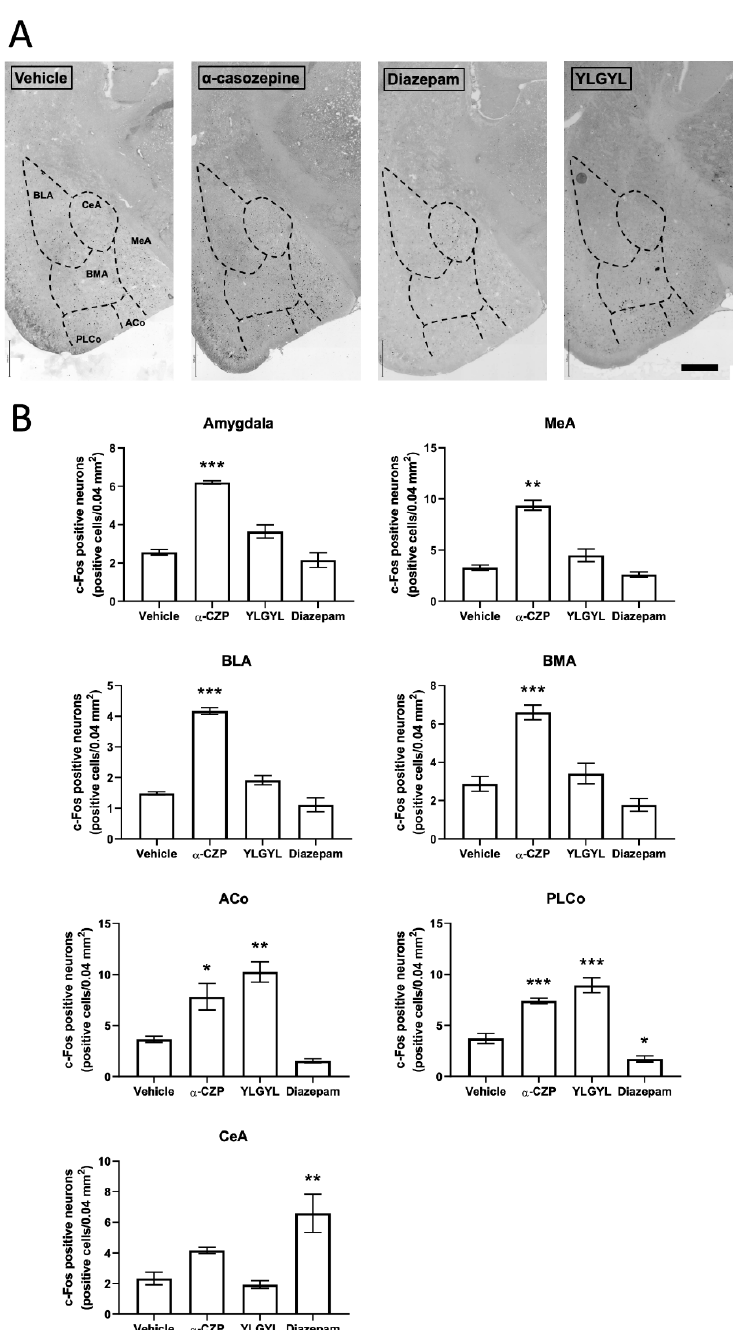
Figure 2. The effects of α - casozepine (α -CZP, 1 mg/kg, IP), YLGYL (0.5 mg/kg, IP), or diazepam (1 mg/kg, IP) on anxiety-induced c-Fos immunoreactivity in the amygdala. ( A ) Photomicrographs displaying the effects of the vehicle, α -CZP, YLGYL, or diazepam on anxiety-induced c-Fos immunoreactivity in the amygdala (coronal sections, bregma − 1.58 mm). The green channel was extracted, and colours were inversed while the contrast was increased to 40% for better visualisation. Scale bar: 500 µm. ( B ) Corresponding densities of c-Fos immunopositive cells (displayed as number of positive cells/0.04 mm 2 ). Data are mean ± SEM ( n = 4/group). Results were analysed using a one-way analysis of variance (ANOVA) followed by a Bonferroni post hoc test to compare the effect of α -CZP, YLGYL, and diazepam to the vehicle (* p < 0.05, ** p < 0.01, *** p < 0.001). ACo: anterior cortical nucleus; BLA: basolateral nucleus; BMA: basomedial nucleus; CeA: central nucleus; MeA: medial nucleus; PLCo: posterolateral cortical nucleus.